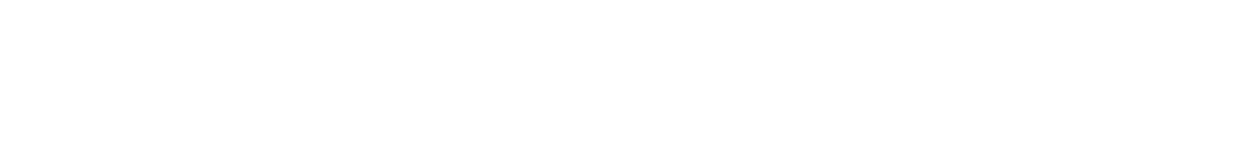
Frontiers in Marine Science |